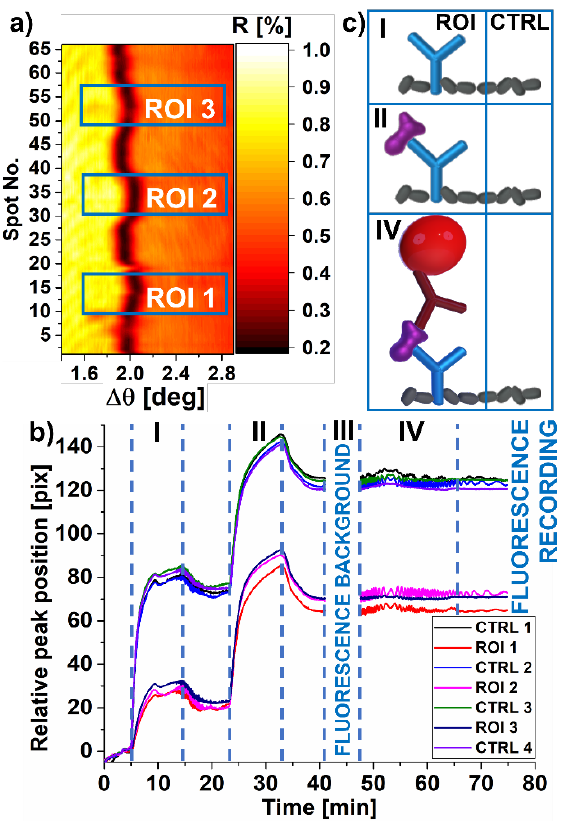
Fig. 2 – In (a) the reflectance angular spectral map along the biochip investigated area is reported. The regions where the three species of antibodies are immobilized are clearly visible. In (b) the real time sensorgrams recorded in Label-Free mode show how the refractive index of the bio-functionalized surface changes when each solution is injected: BSA (I), HER2 in skim milk (II), Detection-IgG* (IV). A surface washing step with PBS 1x follows each injection. Red, pink and dark blue lines refer to ROIs (1,2 and 3 respectively), while black, blue, green and purple lines refer to control regions (listed as CTRL in (c)).